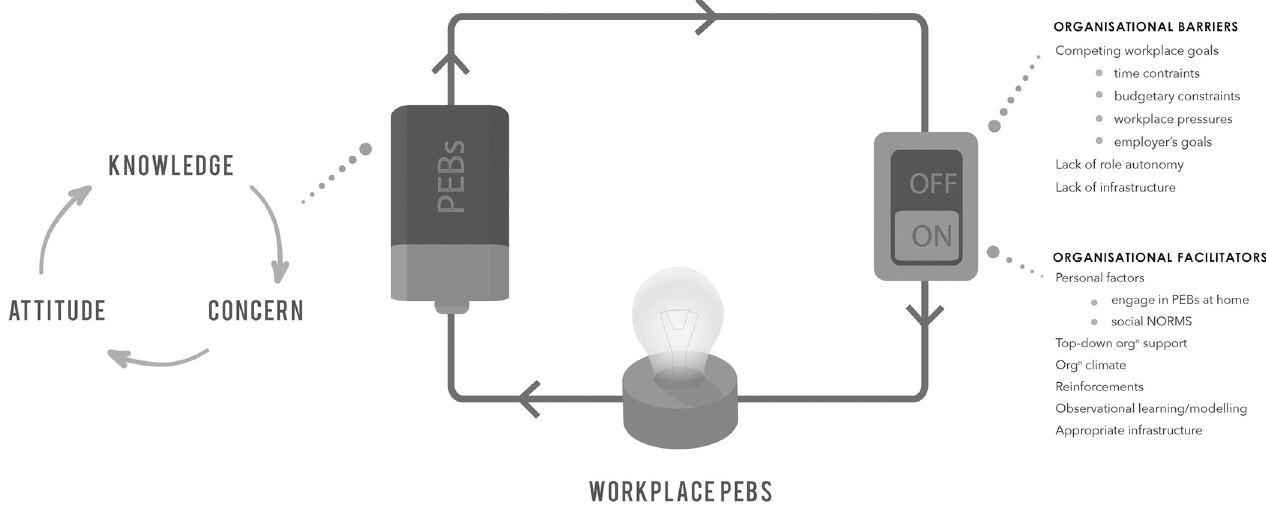
Fig 1. Conceptual framework showing predictor variables of interest for workplace PEBs—environmental attitude, environmental knowledge, environmental concern, and organisational facilitators and barriers.